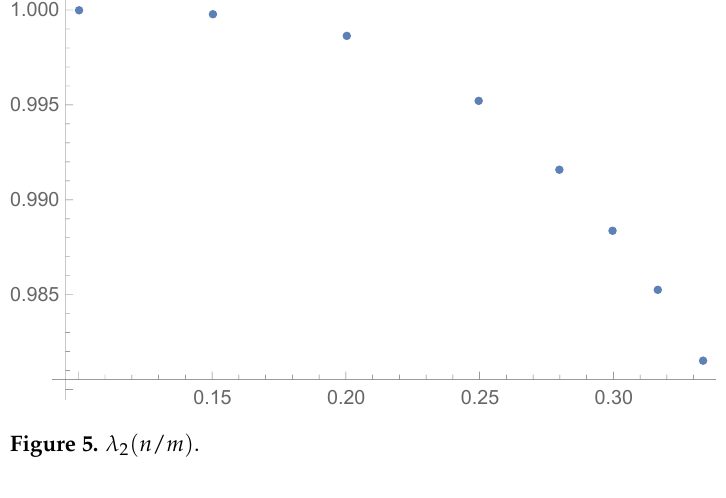
Figure 5. λ 2 ( n / m ) .